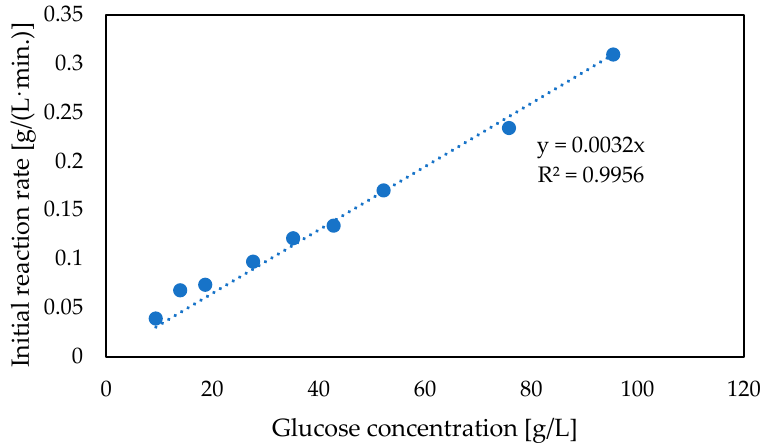
Figure 6. Kinetics of glucose conversion with co-immobilized glucose oxidase and catalase, (GOX 1.33 g/L, CAT 0.22 g/L, capsules volume 3 mL, total volume 18 mL, 0.1 M HEPES buffer pH 6.6, 12 °C, CaCO 3 4 g/L, compressed air 3 L/h).